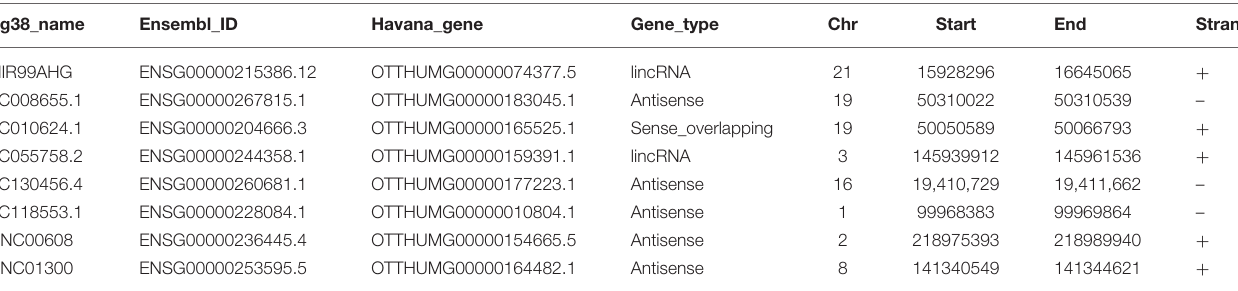
TABLE 1 | Descriptions of the eight lncRNAs.